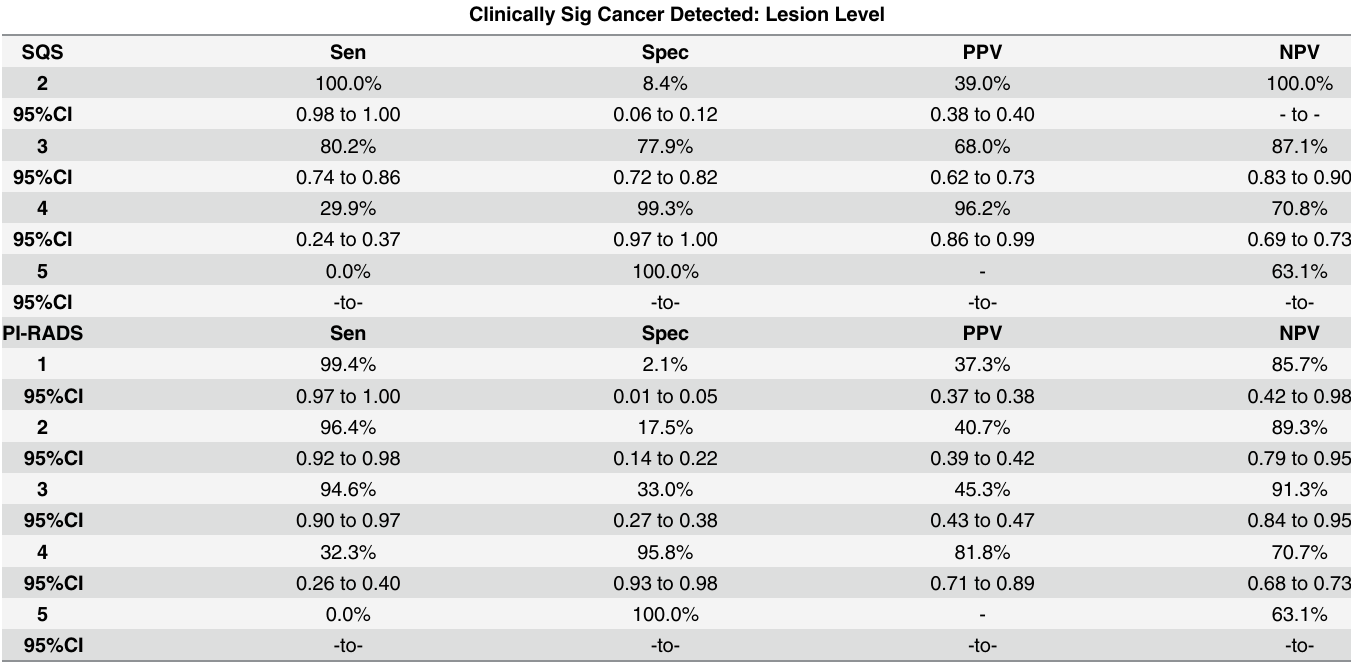
Table 3. Positive Predictive Value, Negative Predictive Value, Sensitivity and Specificity at each cut point in each scoring system for the detection of clinically significant prostate cancer: Lesion-level analysis. Clinically Sig Cancer Detected: Lesion